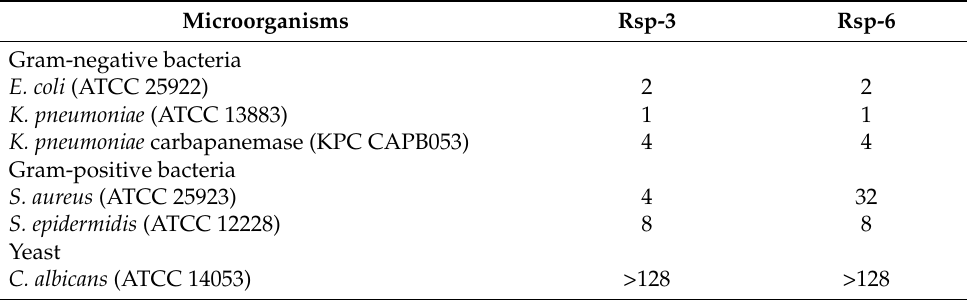
Table 2. Antimicrobial activities of Raniseptins-3 and -6 (MIC in µ M).